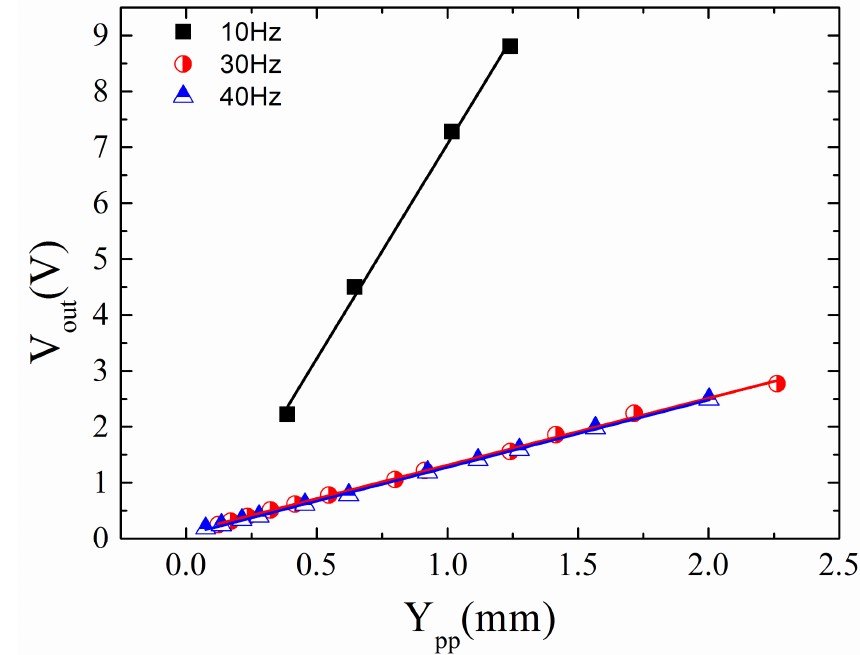
Figure 9. Sensor output signal V out , versus amplitude, Y pp , of vibration of the energy harvester (sensor at rest with respect to the vibrating